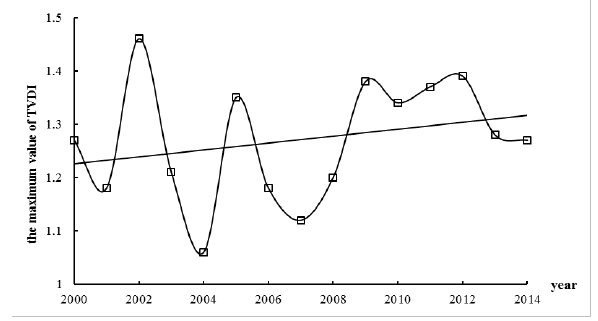
Figure 6. Variation of the maximum TVDI during 2000 to